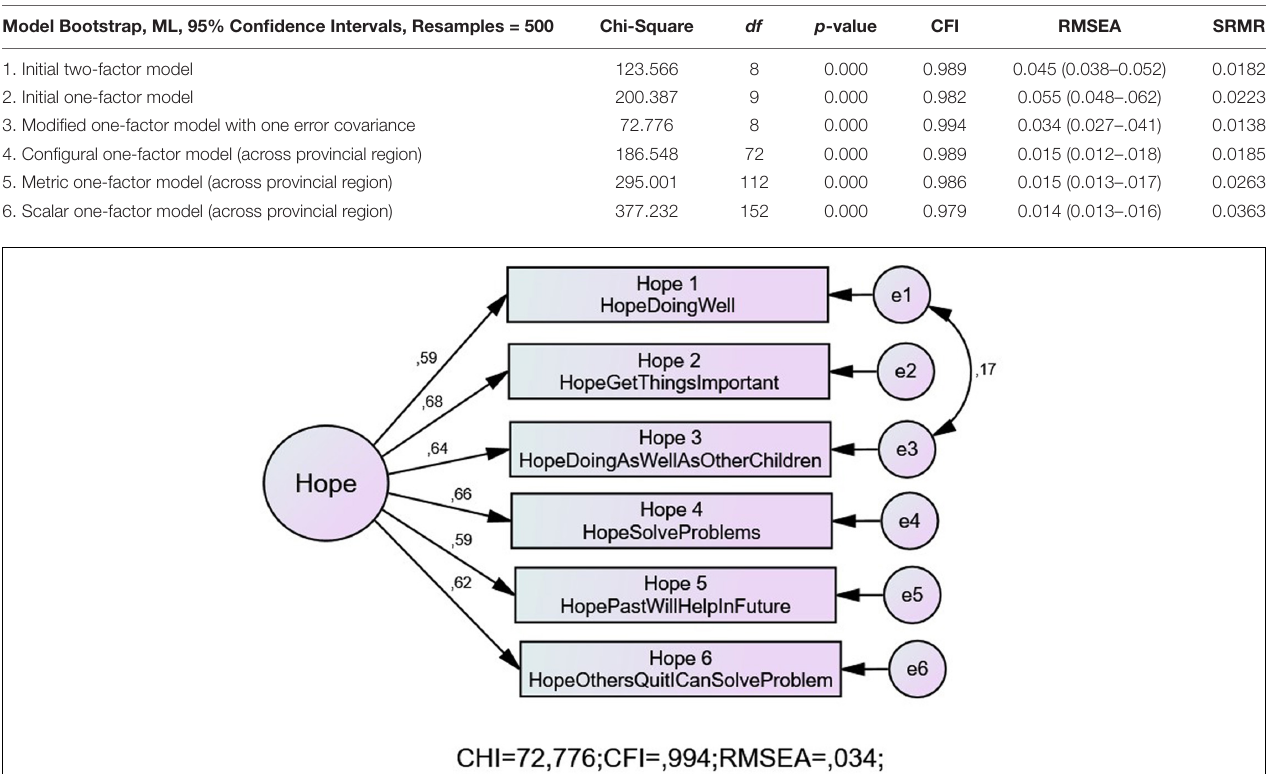
FIGURE 1 | Modified model with one error